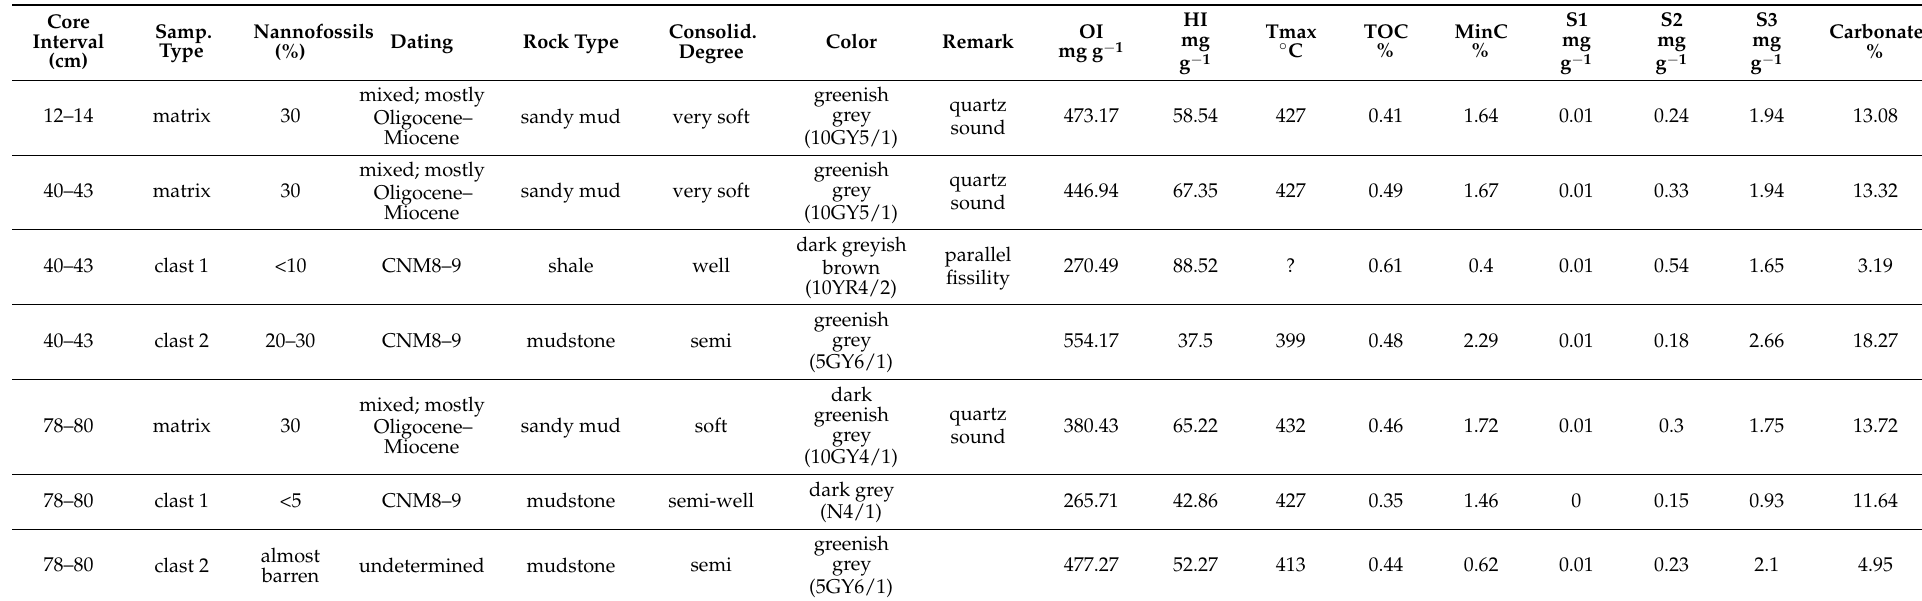
Table A4. Milano MV (LEV7GC